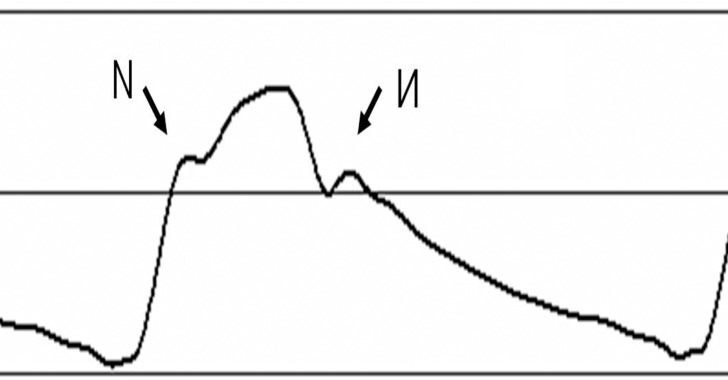
A CPP curve displays the characteristic “N” and “И”.